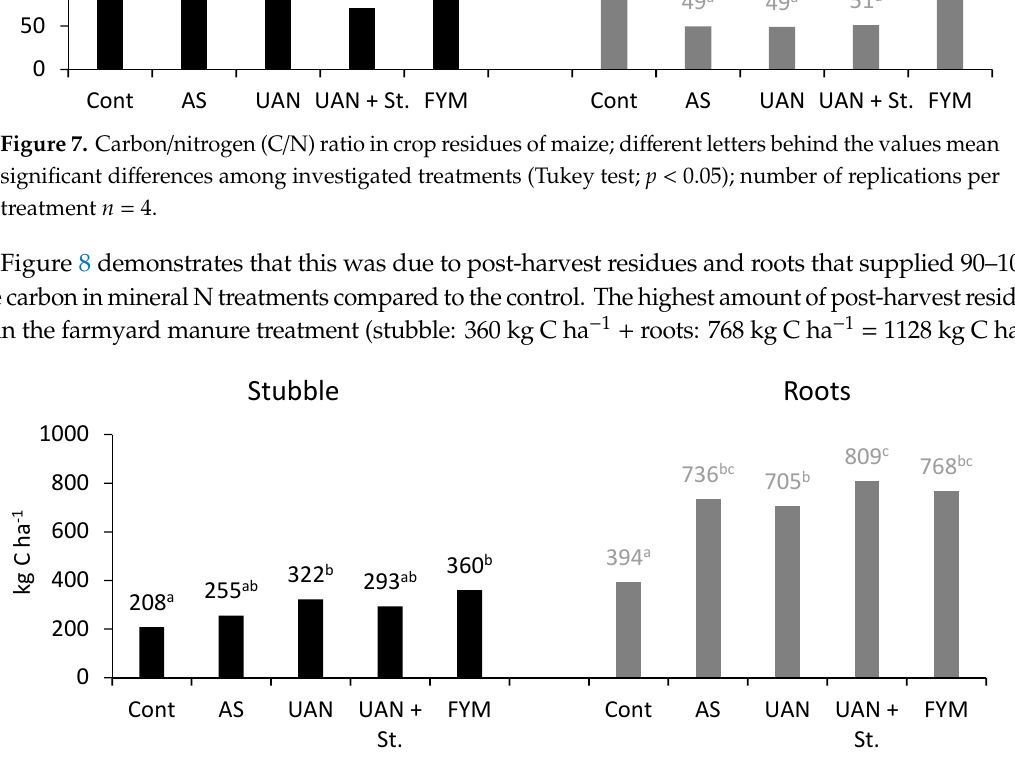
Figure 8. Carbon contents in crop residues of maize; different letters behind the values mean significant differences among investigated treatments (Tukey test; p < 0.05); number of replications per treatment n = 4.